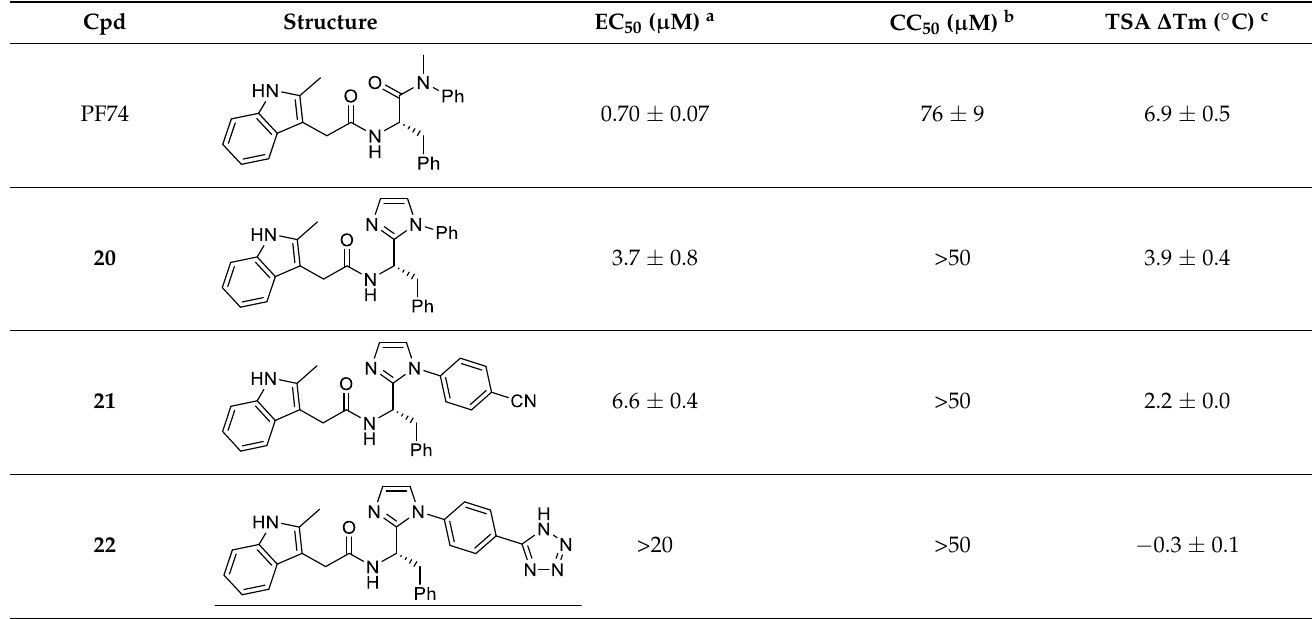
Table 3. Anti-HIV-1 activity, cytotoxicity, and CA hexamer stability profiles of chemotype 3. Cpd Structure